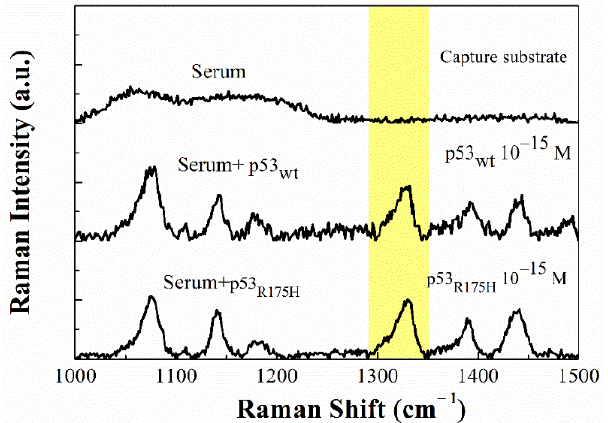
Figure 9. Raman spectra of the capture substrate (functionalized bare healthy human serum) and of functionalized with human serum spiked with p53 wt or p53R175H at 10 − 15 M and incubated with the 4-ATP / NP probe charged with anti-p53 wt . The yellow band highlights the Raman marker peaked at 1328 cm − 1